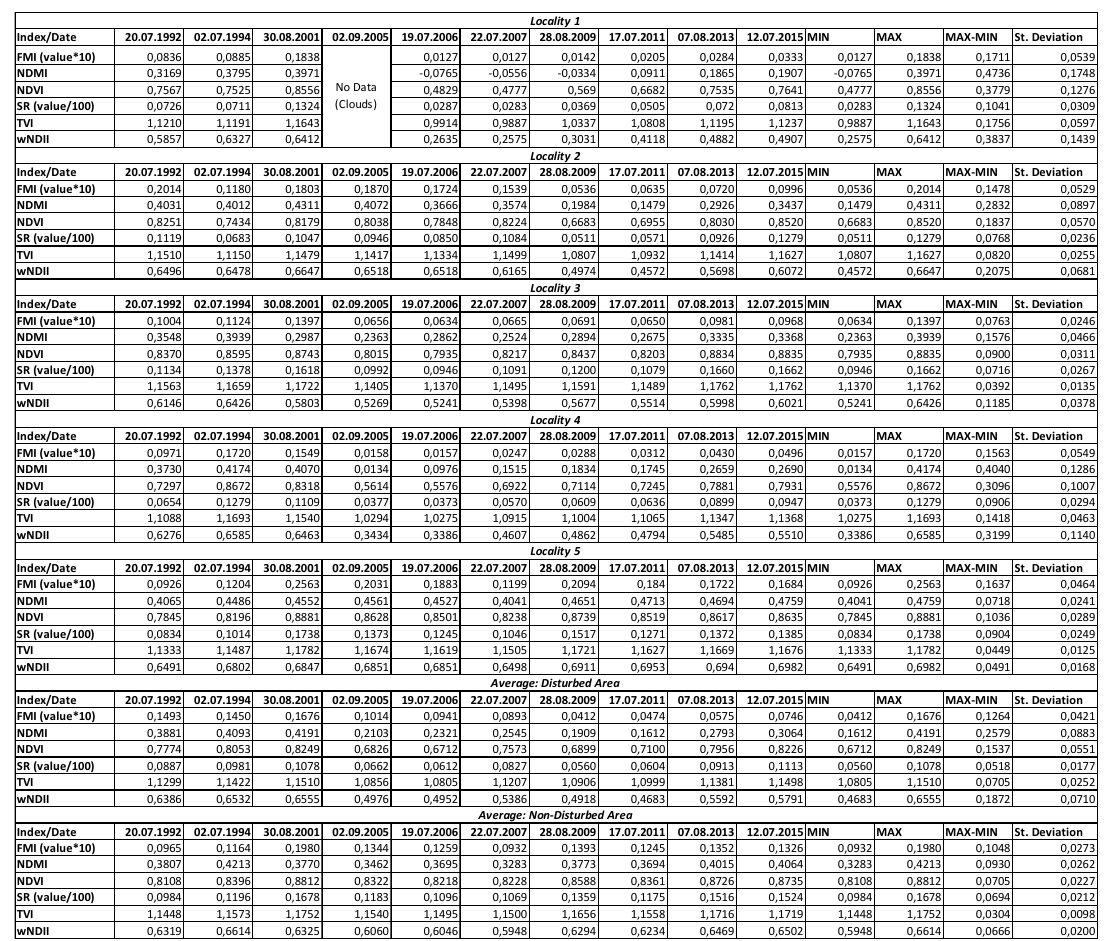
Figure A1. Statistical information about the vegetation indices values in the Low Tatras NP (Source: Own work).